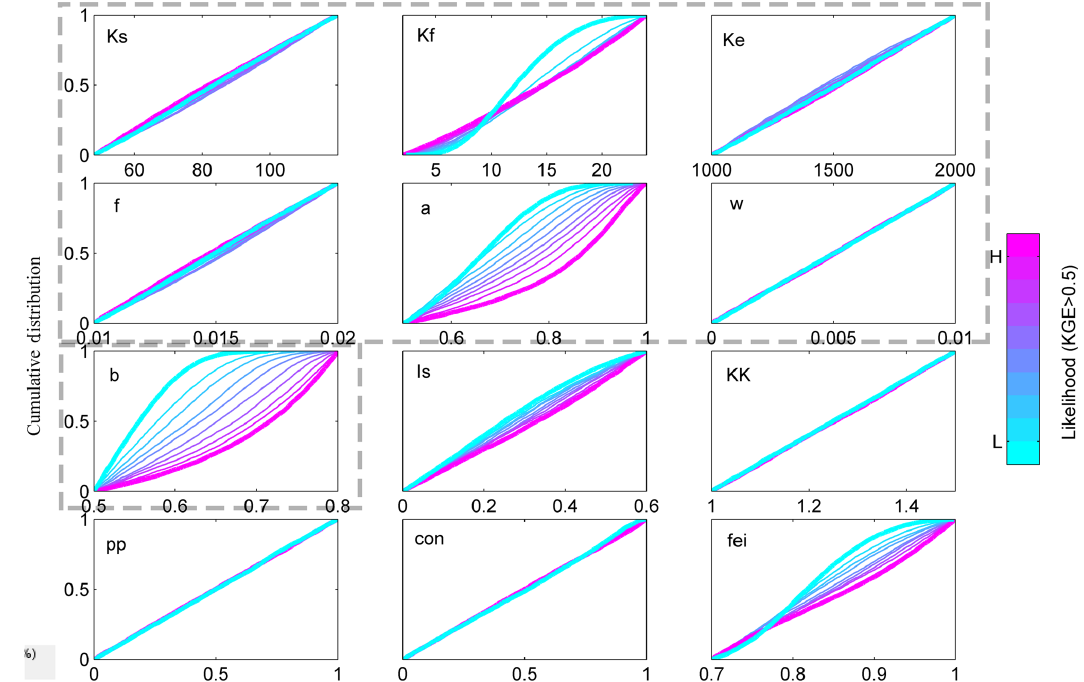
Figure 5. Sensitivity of 12 model parameters expressed as cumulative distributions in 10 levels of likelihood values for the model simulations from the lowest likelihood value (blue) to the highest likelihood value (purple). Likelihood based on KEG and rejection of values <0.5. (The parameters inside the grey dotted box are for flow routing, and the outside parameters are for isotope routing.)